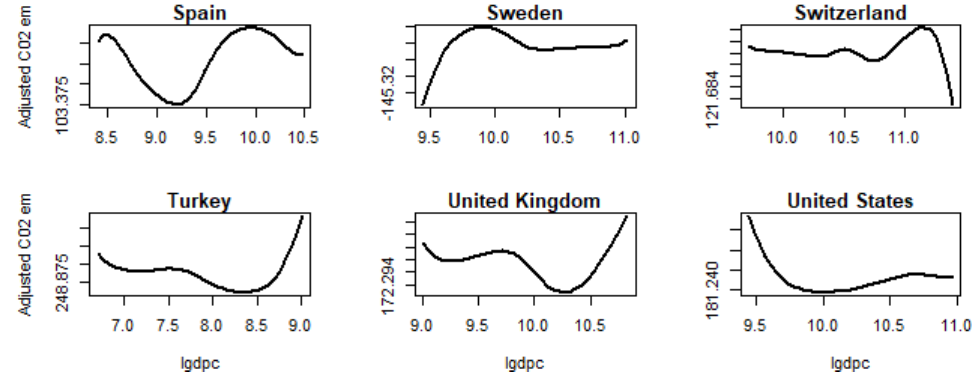
Figure 2. Nonparametric estimates of income-CO 2 emissions for the OCDE countries (Continued).